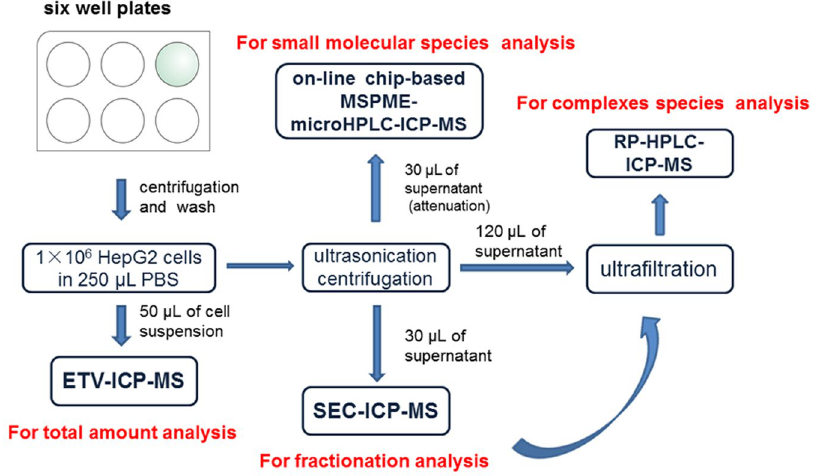
Figure 1. The diagram scheme for the comprehensive analytical platform by using ICP-MS based hyphenated techniques. ETV: electrothermal vaporization; SEC: size exclusion chromatography; RP-HPLC: reversed phase high performance liquid chromatography; MSPME: magnetic solid phase